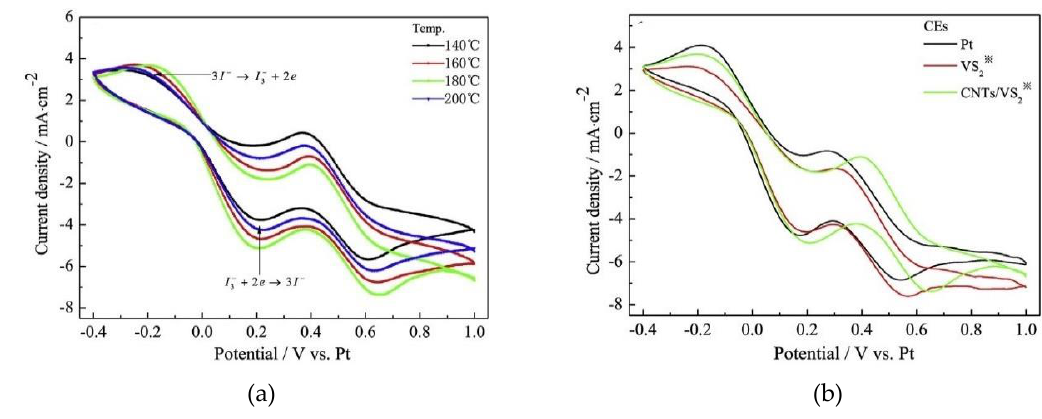
Figure 9. Cyclic voltammetry curves for ( a ) VS 2 /CNT counter electrodes (CEs) synthesized at different temperature conditions, ( b ) various CEs with a scan rate of 50 mVs − 1 . Reproduced with permission from Reference [39], Elsevier 2017.